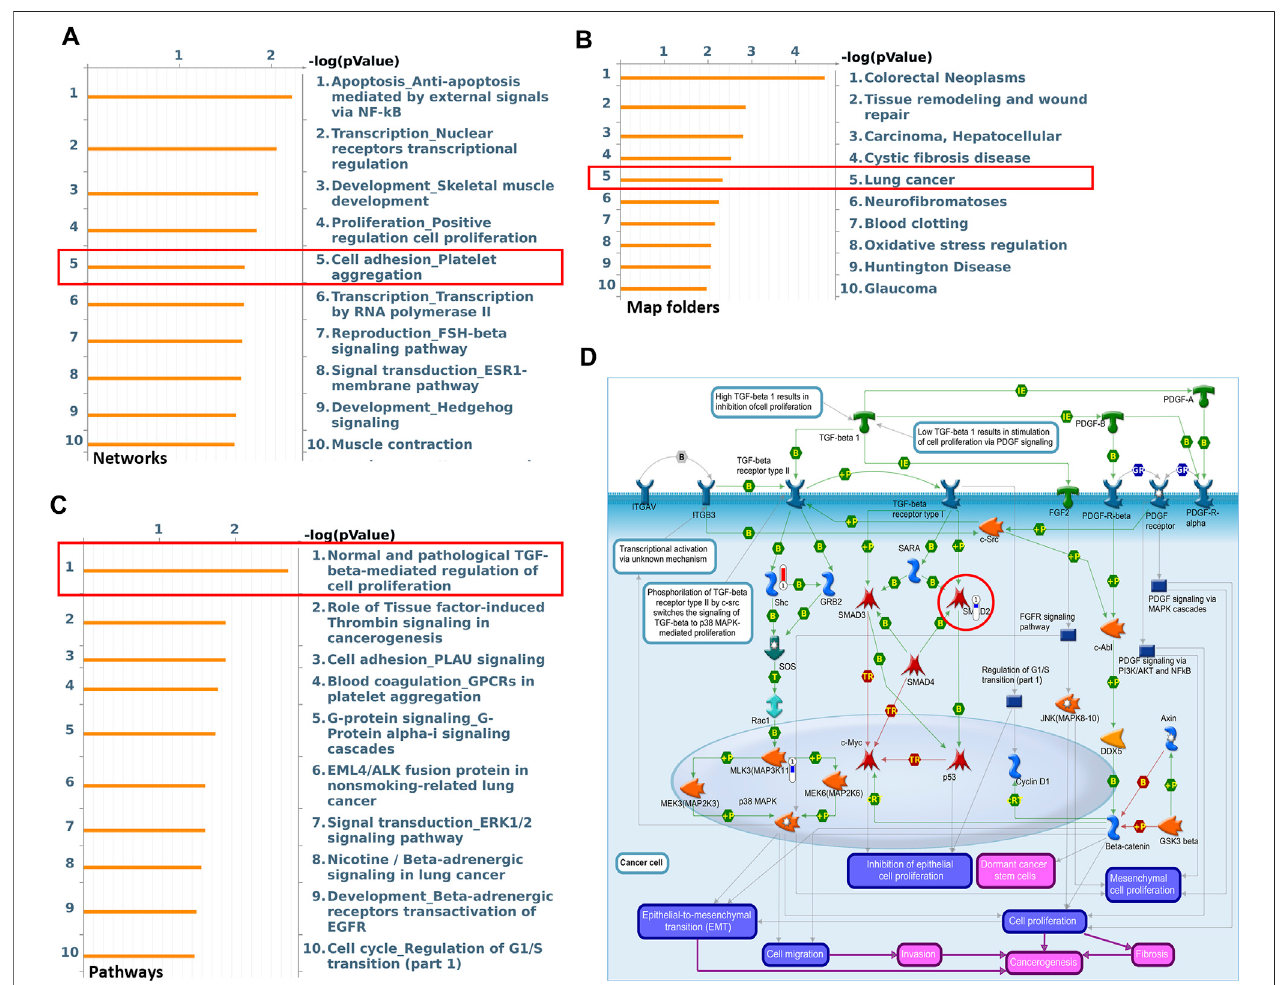
FIGURE3| AK2participatesinlungcancercellmigrationbyregulatingtheEMTprocess. (A,B) Toptenmostsigni fi cantprocess (A) andMapFolders (B) predicted by Metacore TM genego analysis. The results were ordered by -log10 of the p value of the hypergeometric distribution. (C) The top ten most signi fi cant pathway maps related to the lung-cancer map folders. (D) Pathway map related to TGF- β /EMT/Smads signaling axis within the top ten most signi fi cant pathways. Thermometers with blue or red next to symbols show proteins identi fi ed in LC-MS/MS detection: red color represents proteins up-regulated in AK2-knockout A549 cells compared to control group; blue color represents the down-regulated